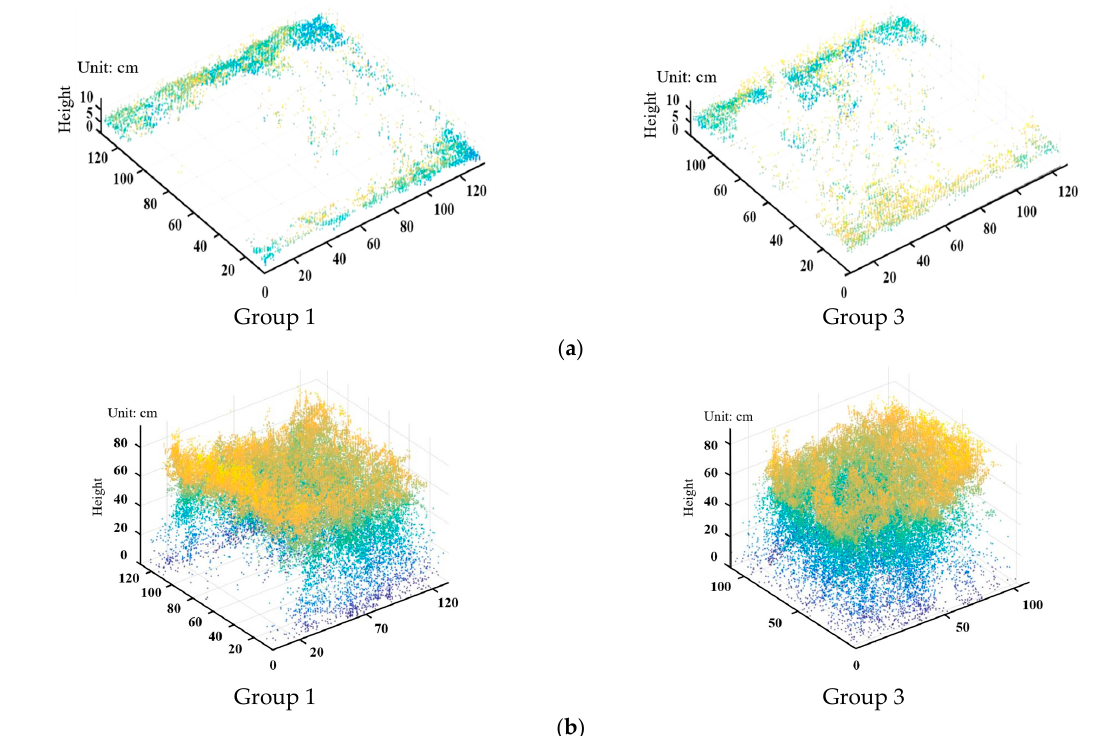
Figure 7. Classification results of ground points and crop points. ( a ) Ground point. ( b ) Crop point.